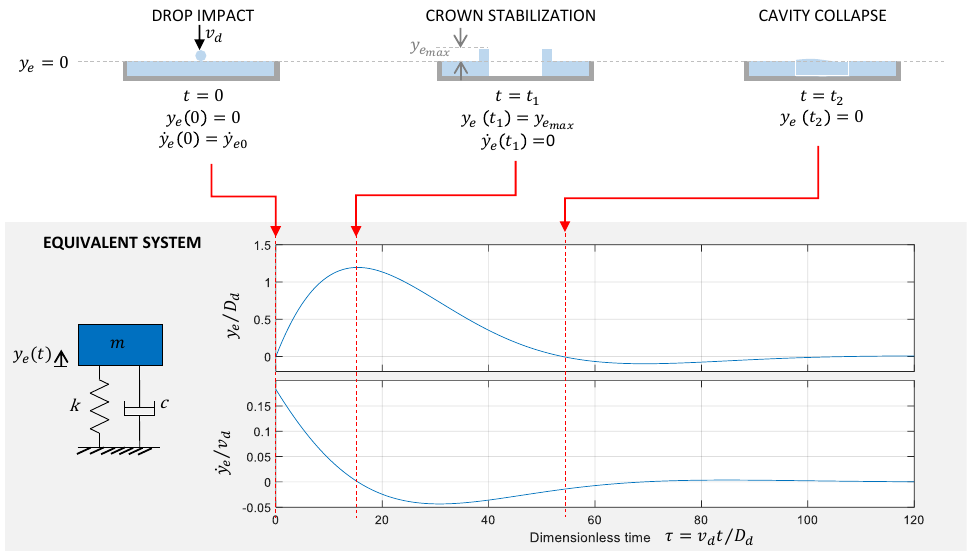
Figure 13. Schematic representation of the phases of a water drop impacting on a medium water film and its time evolution, represented by means of a simplified dynamic